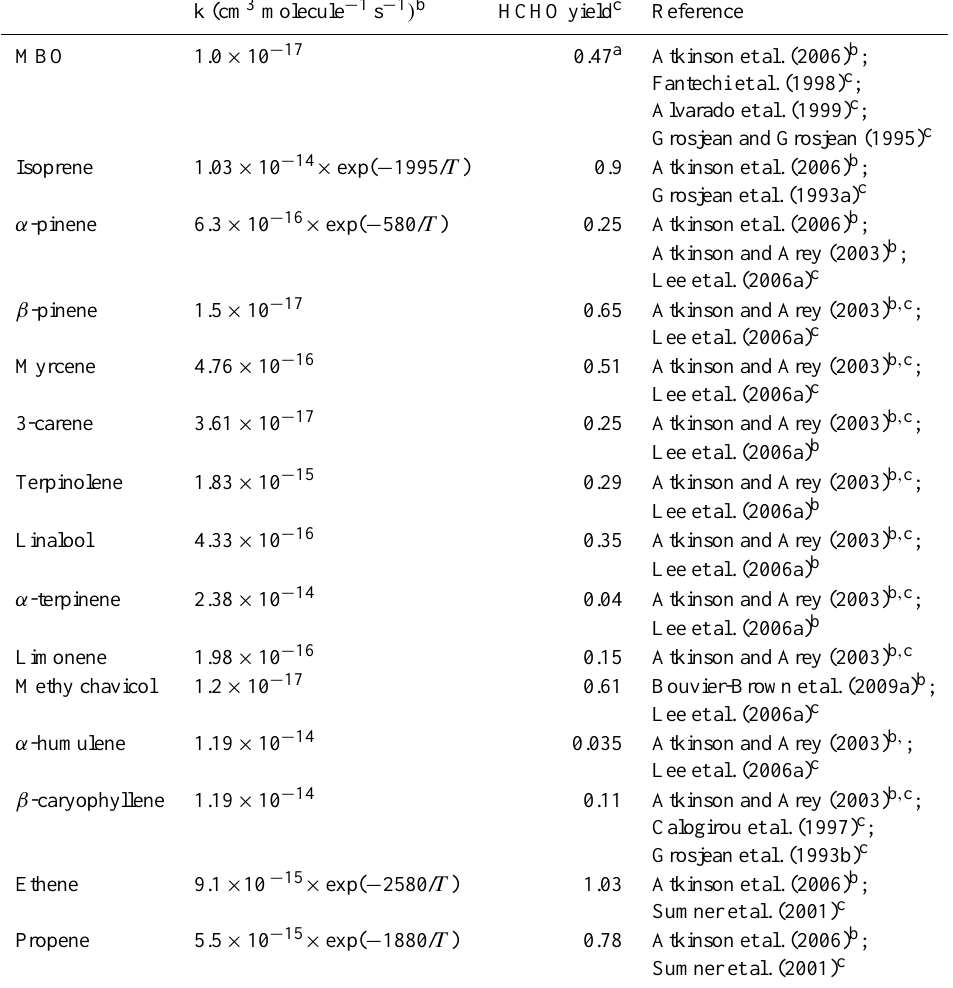
Table 3. Reaction rate constants k and HCHO yield for ozonolysis of VOCs that are at least partially